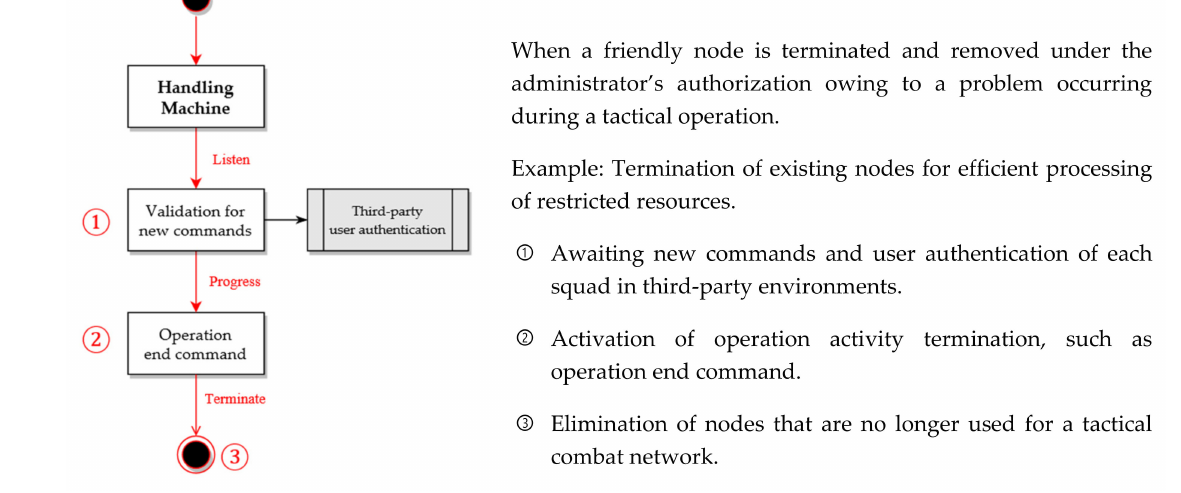
Figure 7. Scenario 3—based exception handling